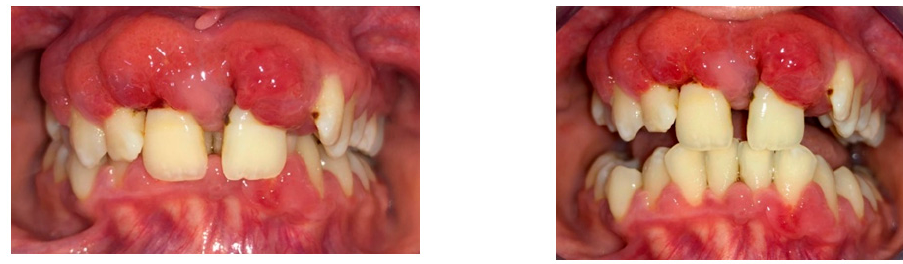
Figure 4. Clinical aspects at the second presentation (3 days after initial examination).